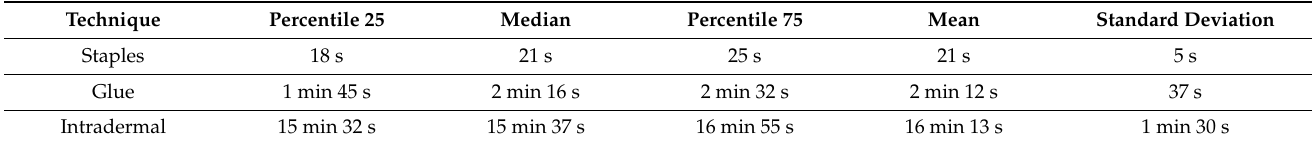
Table 1. Time (minutes/seconds) required for completion of each technique, all the differences being significant ( p < 0.001).